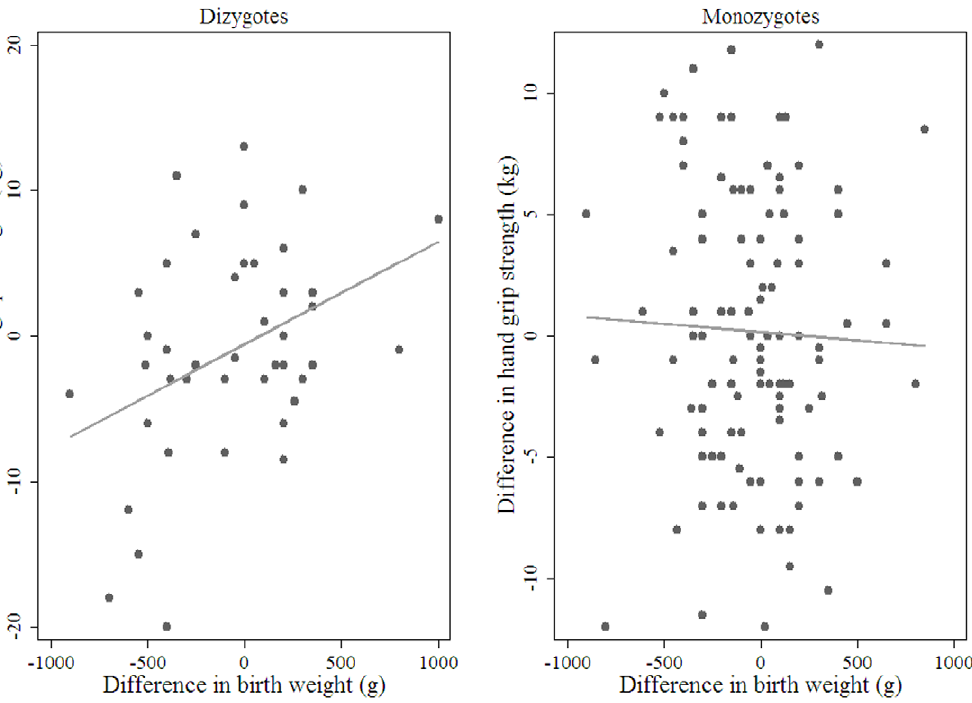
Figure 1. Between pair difference in birth weight and between pair difference in adult hand grip strength in men n=156 male pairs (n=43 MZ, n=113 DZ).